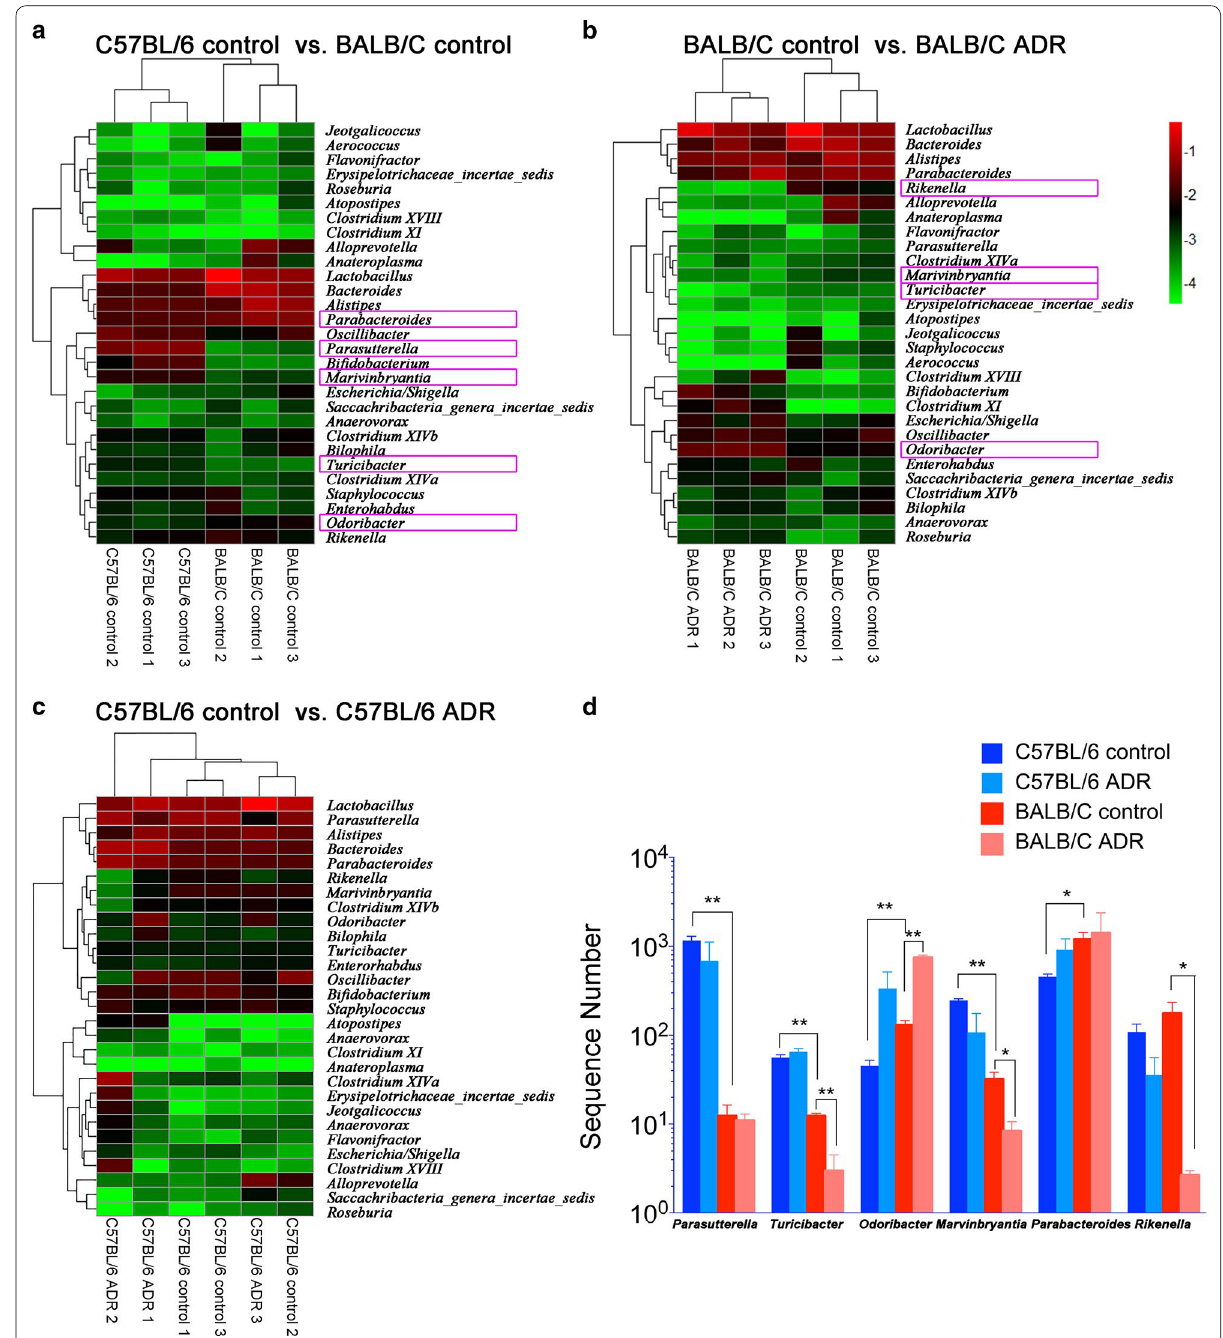
Fig. 3 Gut microbiome altered with ADR at genus level. a The gut microbiome composition of C57BL/6 control group and BALB/C control group; b the gut microbiome composition of BALB/C ADR group and BALB/C control group; c the gut microbiome composition of C57BL/6 ADR group and C57BL/6 control group; d certain genera that were significantly different between BALB/C and C57BL/6 mice or had changed after ADR treatment. *p < 0.05; **p <